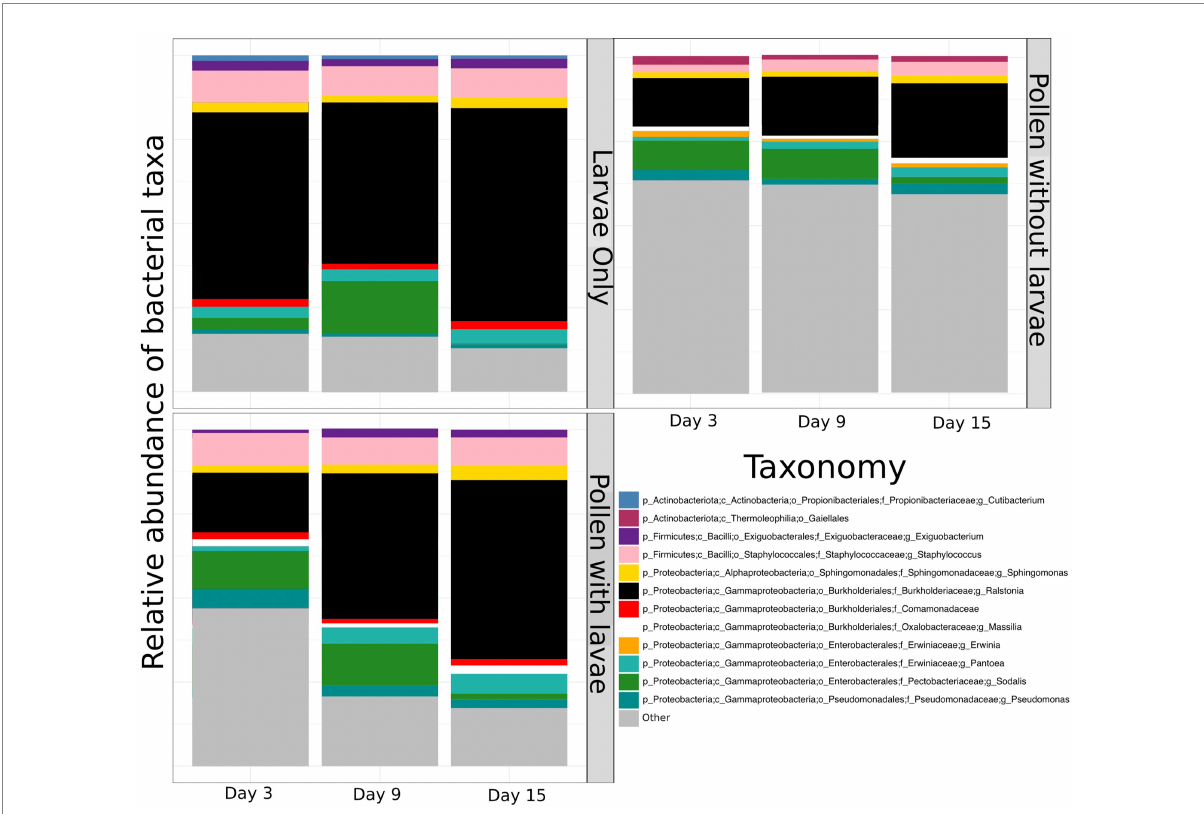
FIGURE 3 The proportional abundance of dominant bacterial ASVs of pollen and Osmia cornifrons summarized across sampling days. Proportional abundances are displayed for three treatment groups, larvae only, pollen with larvae, and pollen without larvae.